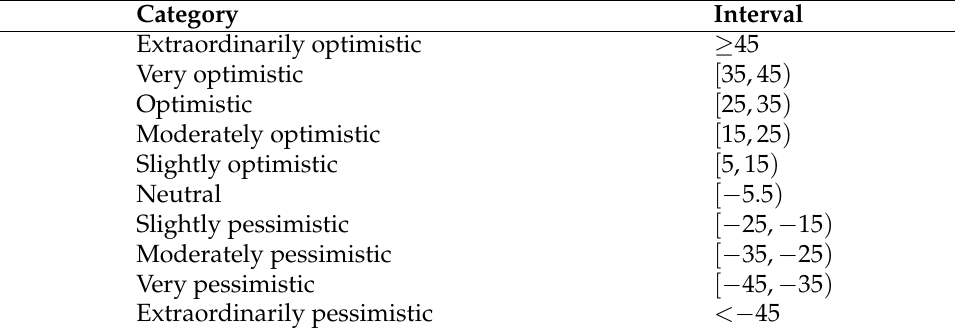
Table 1. Business Confidence Index qualitative